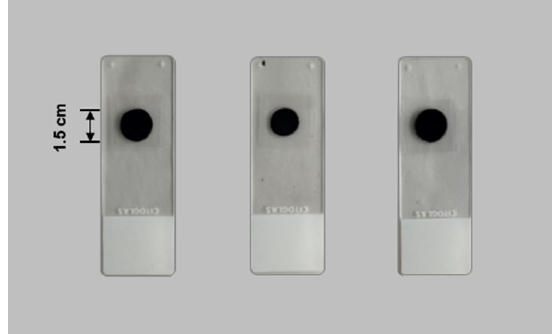
Figure 2. Asphalt sample for the CLSM test.